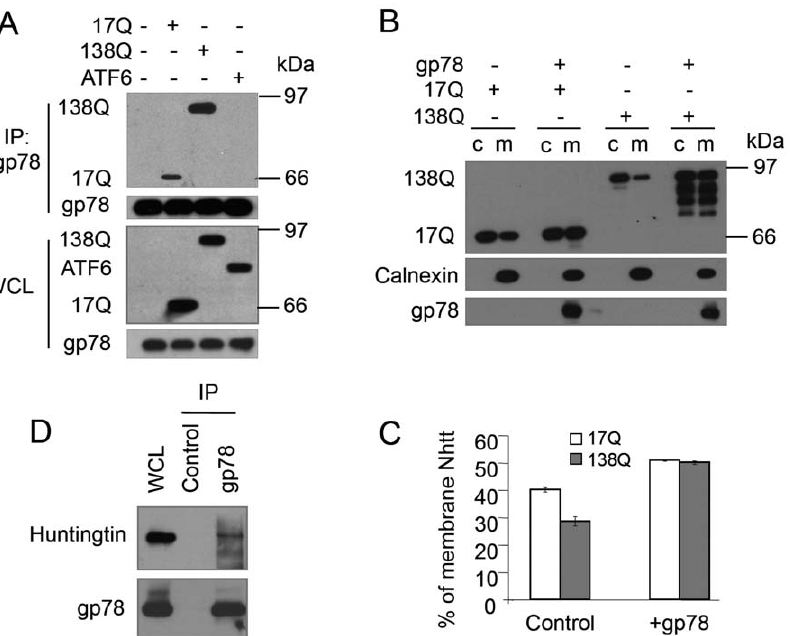
Figure 2. gp78 interacts with htt. A. gp78 interacts with Nhtt and polyglutamine expansion increases the interaction. Nhtt17Q and Nhtt138Q were expressed in HEK293 cells. FLAG-ATF6 and empty vector was used as controls. Immunoprecipitation was performed with anti-gp78 antibody followed by immunoblotting with the antibodies as indicated. B, C. gp78 enhances Nhtt association with the microsomes. HEK293 cells fractionated as indicated were subjected to fractionation into microsomal membranes (m) and cytosol (c). gp78 and Nhtt were detected by immunoblotting using anti-gp78 and anti-FLAG antibodies. Calnexin was blotted as an ER marker. Microsome-associated Nhtt was expressed as a percentage of total Nhtt associated with microsomes and in the cytosol (Mean 6 SD, n =3). D. Endogenous gp78 associates with htt. HEK293 cells were lysed in RIPA buffer and gp78 was immunoprecipitated with anti-gp78 antibody clone 2G5. Endogenous htt was detected by immunoblotting.